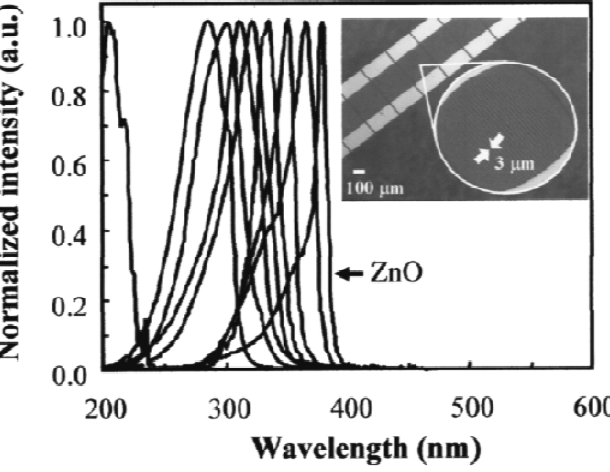
Figure 17. Normalized spectral response of an array of UV photodetectors based on a composition spread of Mg Zn O. The active area of each device was 25 0 × 220 µ m 2 . x 1-x Composition variation within each detector is less than 2.4 mol %. The inset of Figure 18 shows an enlarged picture of interdigited electrodes used as detectors. Each finger width and the finger separation is 3 mm